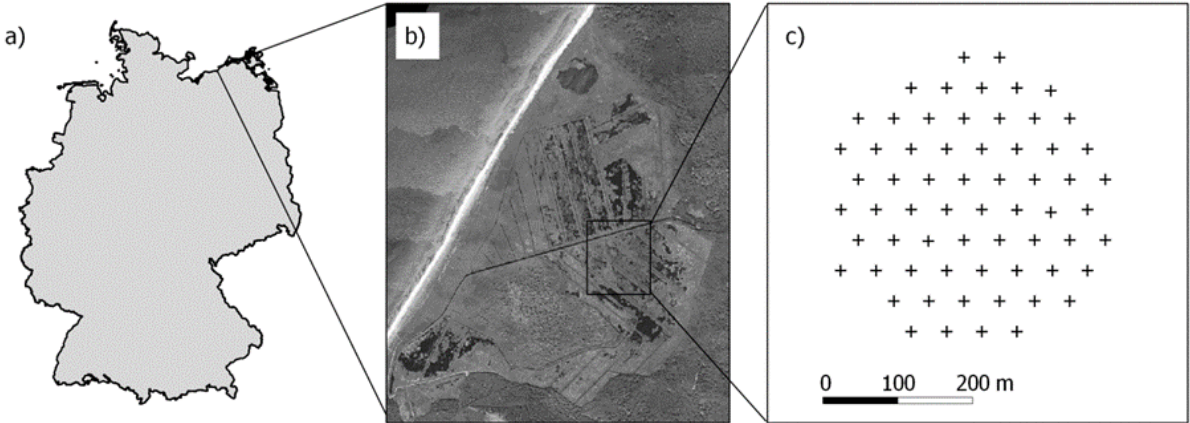
Figure 1. a) Location of the study site within Germany; b) aerial image of the nature reserve “Heiligensee und Hütelmoor” showing the study area; c) positioning of sampling points within the study